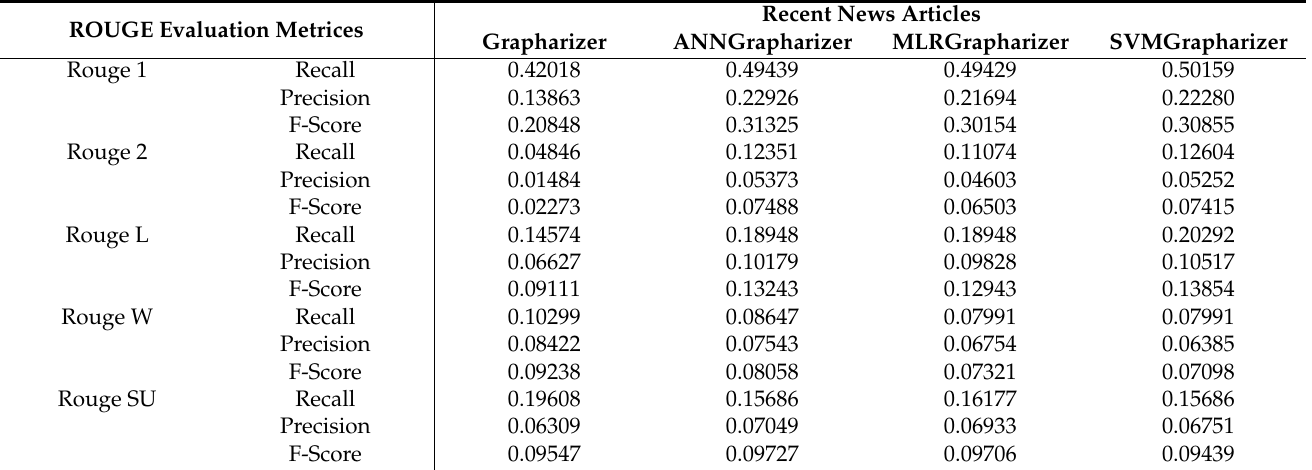
Table 4. Performance of Grapharizer and its ML variants on Recent News Articles